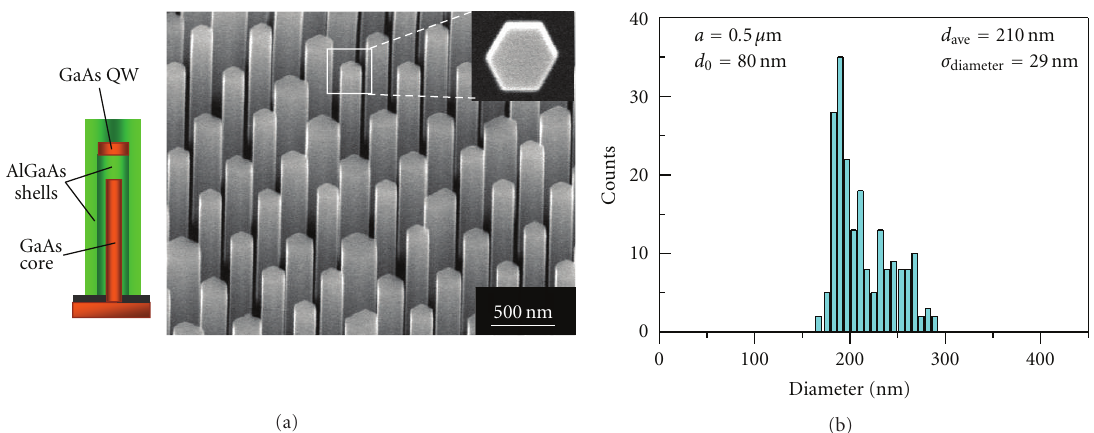
Figure 8: SEM images and schematic of structure of heterostructure NWs and distribution of diameters. (a) SEM images of grown NWs and schematic of cross-sectional structure of NW containing GaAs QW. GaAs cap layer is not shown in schematic. Inset SEM image in upper right is top view of NW. (b) Histogram of diameter distribution for NWs with pitch of a = 0 . 5 μ m [30].